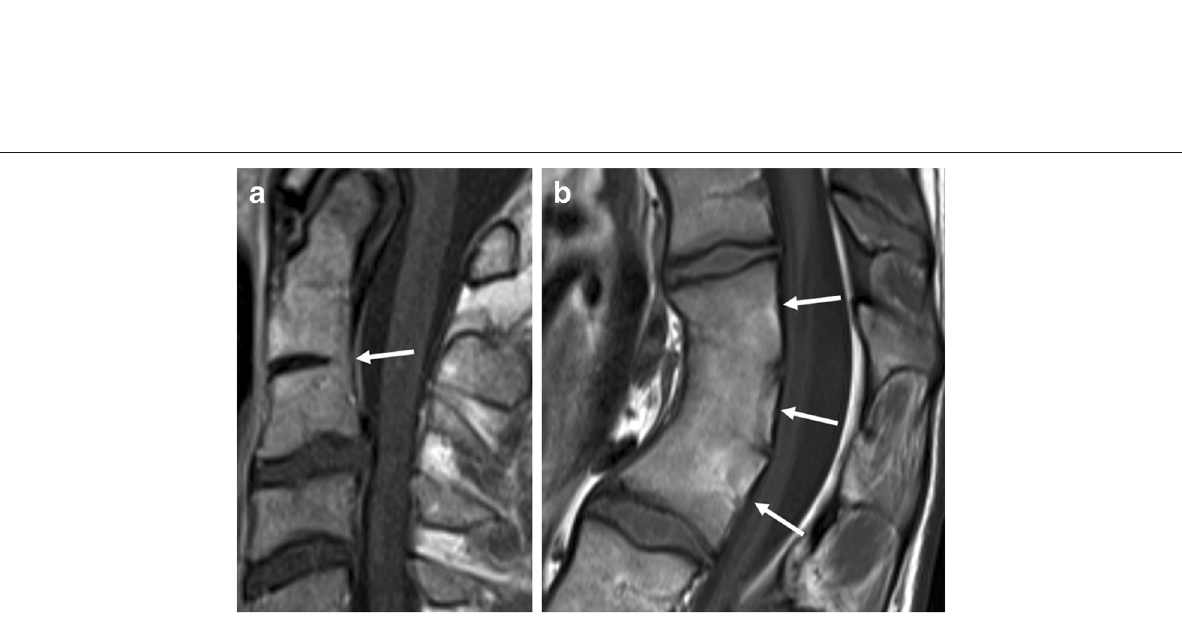
Fig. 11 Pitfalls in imaging and diagnosis of new bone formation: congenital block vertebrae. Sagittal T1-weighted MR images show ( a ) partial congenital block vertebra of C2-C3 (arrow) and ( b ) complete congenital block vertebra consisting out of three vertebrae (arrows). Note the narrowed antero-posterior diameter in b , a typical sign of complete congenital fusion. Also, note that the height in b is less than the expected sum of three vertebrae and two intervertebral